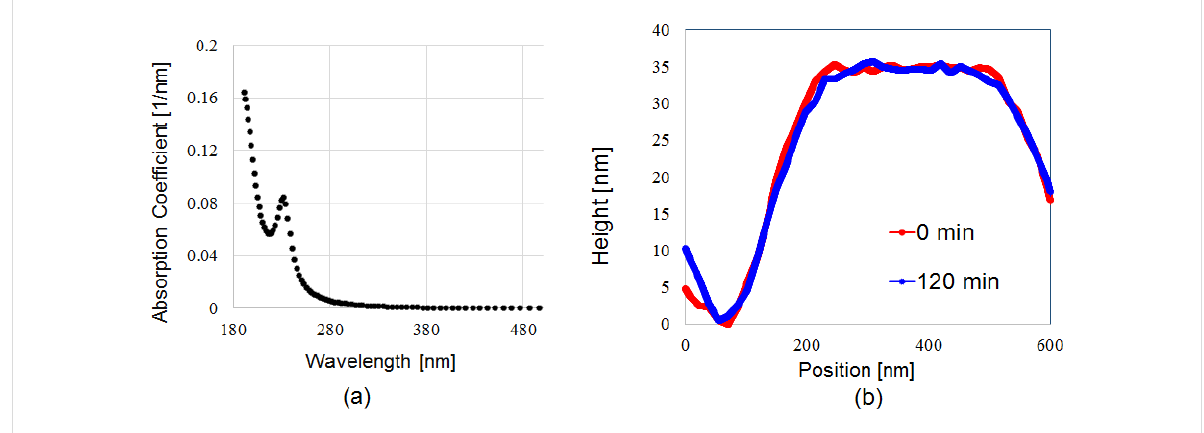
Figure 4: Absorption spectrum and cross-sectional profile. (a) Photoresist absorption curve, showing that 325 nm and 405 nm are not directly being absorbed by the photoresist. (b) Near-field etching for 120 min with 325 nm He–Cd laser, repeated under a low-oxygen environment.